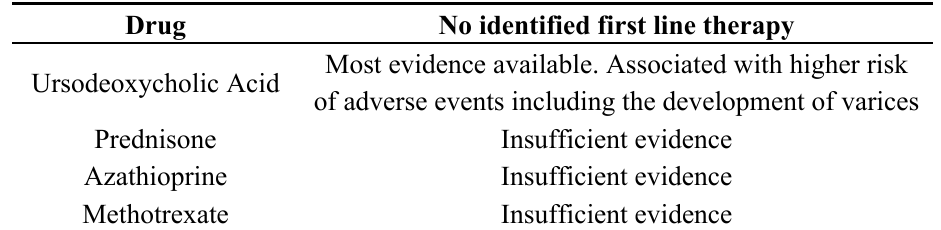
Table 3. Immunosuppressive Pharmacotherapy—Primary Sclerosing